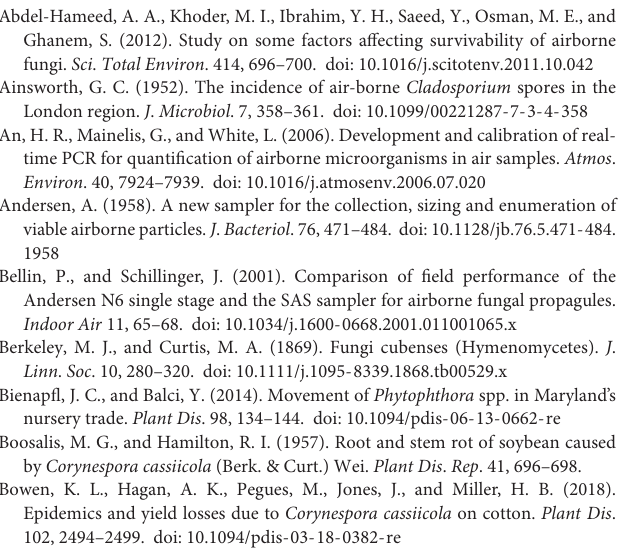
Supplementary Figure 4 | Symptoms observed in the transmission experiment among donor and recipient cucumber plants in greenhouses at 10, 20, 30, 40, 50, and 80 days post inoculation (dpi). Donor cucumber plants were inoculated by spraying 1 × 10 5 spores/mL hygromycin-resistant Corynespora cassiicola spore suspension in the inoculation center at 0 dpi. Sampling sites were 0, 1.5, 3, 4.5, 6, and 7.5 m away from the inoculation center. Supplementary Table 1 | Sampling and detection of Corynespora cassiicola aerospores in naturally infested greenhouses. Supplementary Table 2 | Quantification of Corynespora cassiicola aerospores by culturing and qPCR methods. Supplementary Table 3 | Size distribution of Corynespora cassiicola aerospores generated by cucumber after artificial